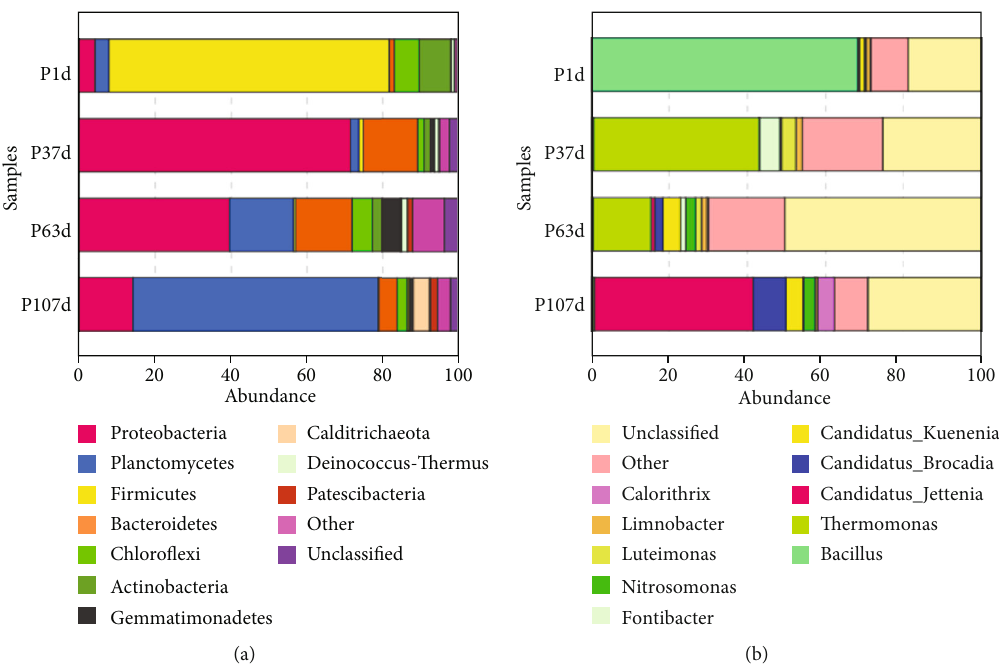
Figure 4: Bacterial community composition at the phylum (a) and genus (b) levels in the CANON process after alkaline